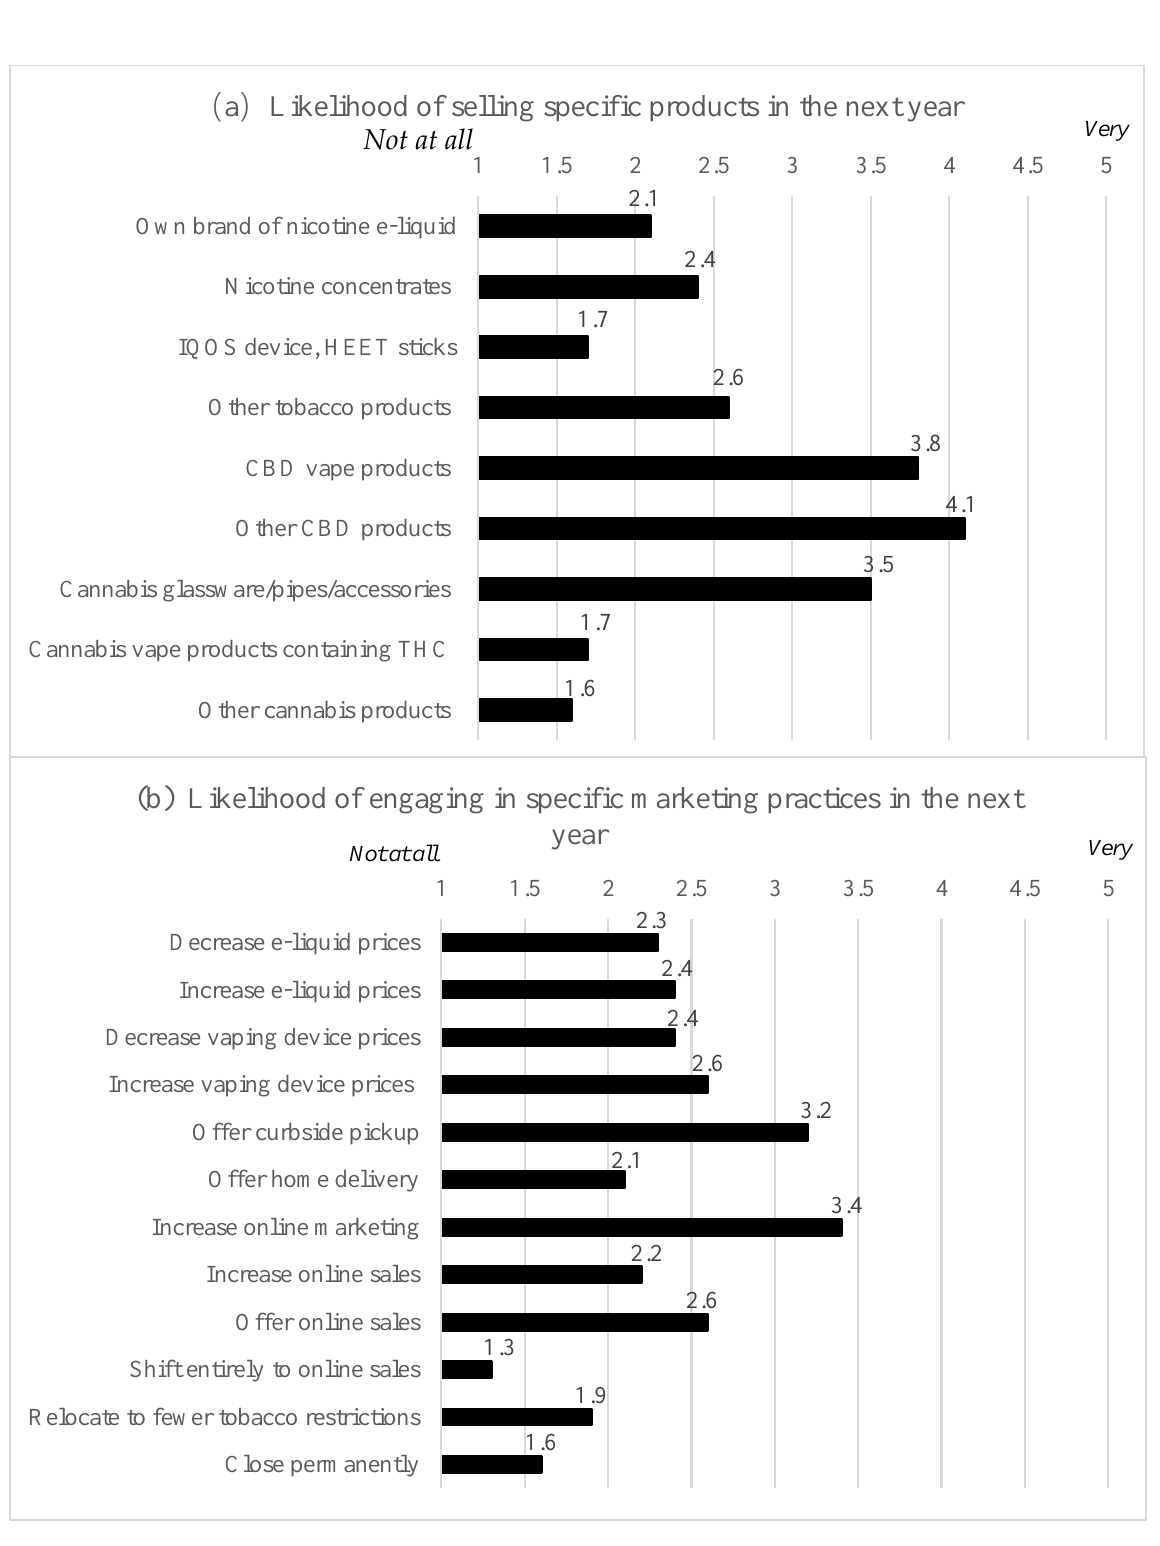
Figure 1. ( a ) Likelihood of selling specific products in the next year. ( b ) Likelihood of engaging in Figure 1. Likelihood of selling specific products and engaging in specific marketing practices in the specific marketing practices in the next year. (Notes: All 2-sample t -test p - values ≥ 0.05 for vape next year. (Notes: All 2-sample t -test p -values ≥ 0.05 for vape shops vs. vape-and-smoke shops, shops vs. vape-and-smoke shops, except for selling: own brand of nicotine e-liquid (mean (M) = 2.5 except for selling: own brand of nicotine e-liquid (mean (M) = 2.5 vs. M = 1.6, respectively, p = 0.027); vs. M = 1.6, respectively, p = 0.027); IQOS device and/or IQOS HEET sticks (M = 1.4 vs. M = 2.0, p = IQOS device and/or IQOS HEET sticks (M = 1.4 vs. M = 2.0, p = 0.040); other tobacco products 0.040); other tobacco products (M = 1.3 vs. M = 4.1, p < 0.001); and glassware, pipes, and accessories (M = 1.3 vs. M = 4.1, p < 0.001); and glassware, pipes, and accessories for cannabis (M = 2.9 vs. M = 4.1, for cannabis (M = 2.9 vs. M = 4.1, p = 0.013)). p =